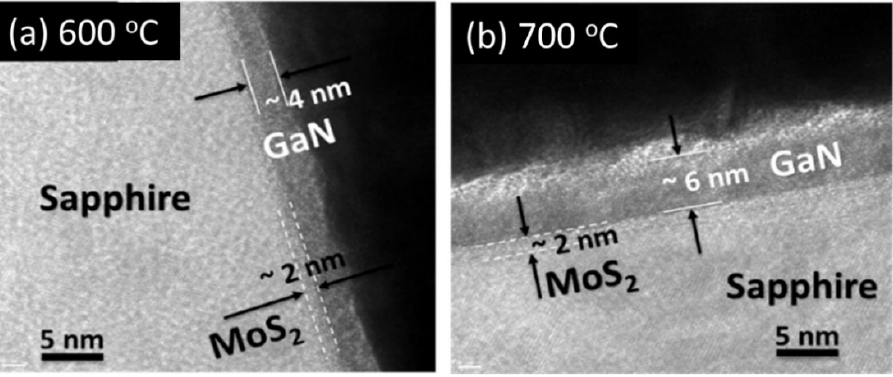
Figure 8. TEM images in the cross-section of GaN/MoS 2 /sapphire for ( a ) T2 and ( b ) T3 samples.